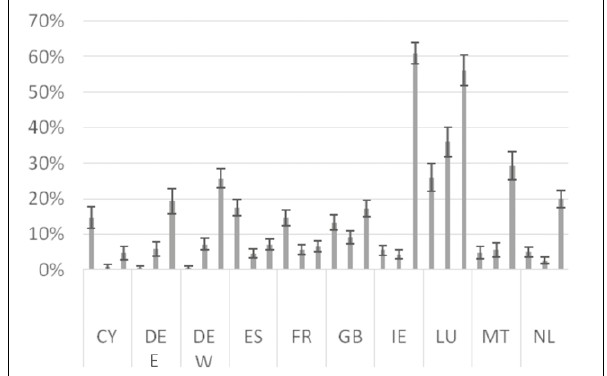
Figure 1a: The percentage of people saying housing is a countrywide problem (2008, 2013, 2018), selected countries